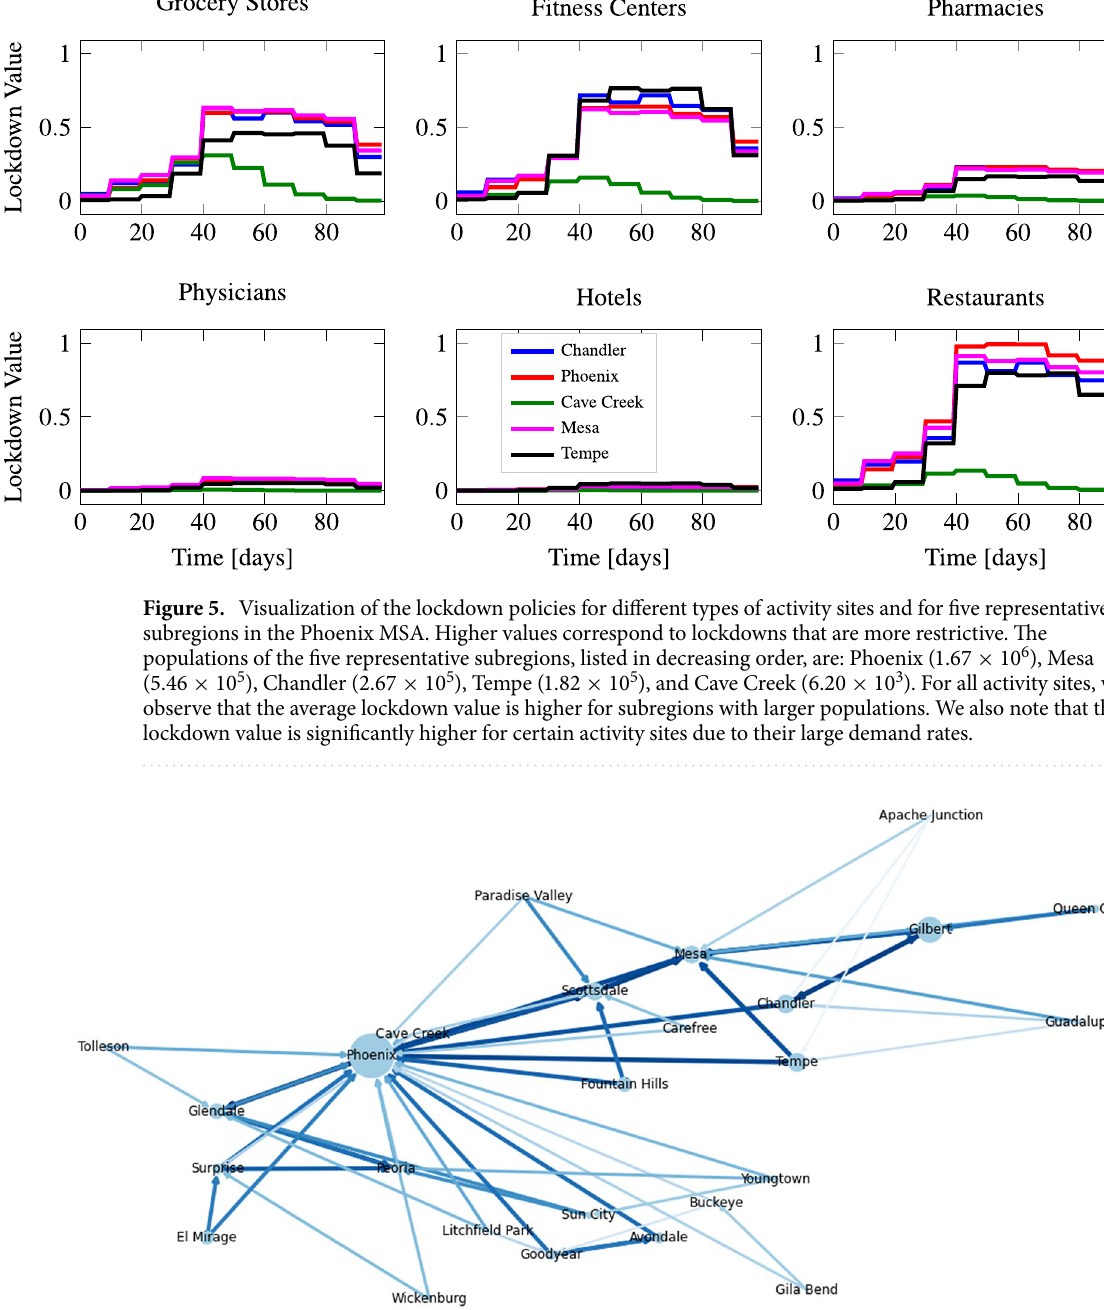
Figure 6. Visualization of the average number of interactions between subregions that results from the solution to the optimization problem for Phoenix MSA. Each node in the visualization graph represents a subregion; node sizes are proportional to the population of the corresponding subregion. Directed edges between subregions visualizes interactions between their populations. The direction of the edge represents the direction of travel: members of the origin subregion’s population visit activity sites within the target subregion, and then return to their home subregion. Increasing edge widths and darker colors for the edges represent a larger number of people that are traveling between